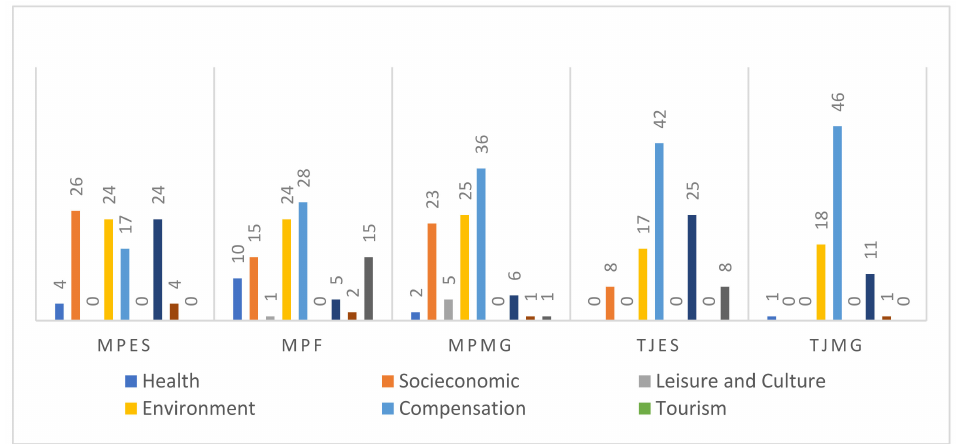
Figure 5. Relative distribution of themes in the disaster in Mariana according to legal